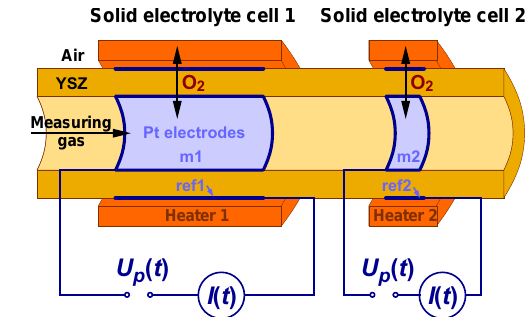
Figure 2. Characteristic curves of the solid electrolyte cell 1; cell temperature: 750 ◦ C; potential scan rate: 100mVs − 1 ; gas flow rate: 10sccm; electrode size: 7.5cm 2 ; open-circuit potential of the cell with N 2 as measuring gas: − 183 . 5mV (dashed lines). Inset: mag- nification of the curve with N 2 as measuring gas in the range of − 0 . 5 to